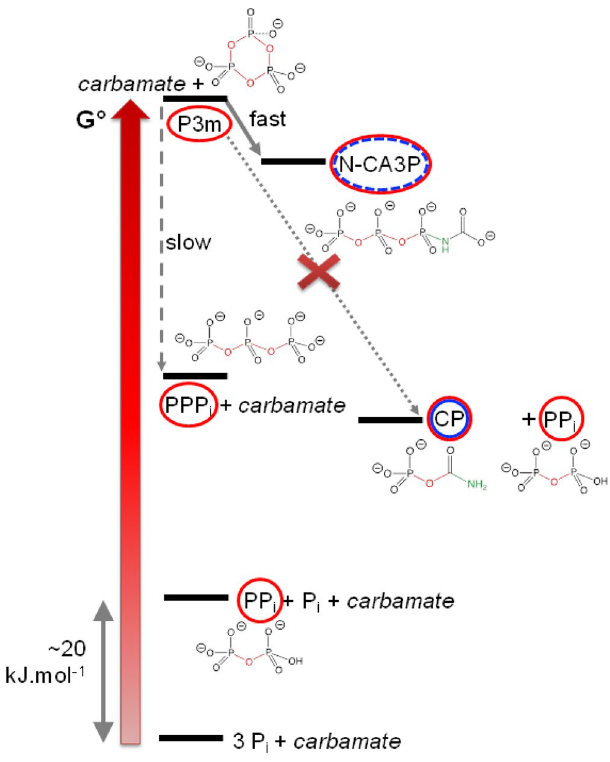
Figure 5. A partial energetic view of P3m degradation reactions in aqueous solutions containing carbamate. Thermodynamic data from Pasek 24 have been